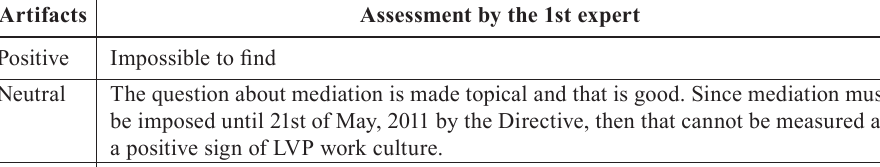
Table 1. Qualitative evaluation of the work culture as carried out by LVP in relation to MIP